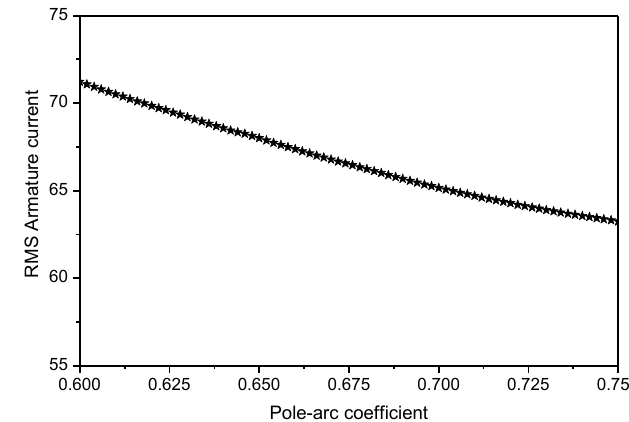
Figure 6. Relation curve between pole-arc coefficient and armature current.